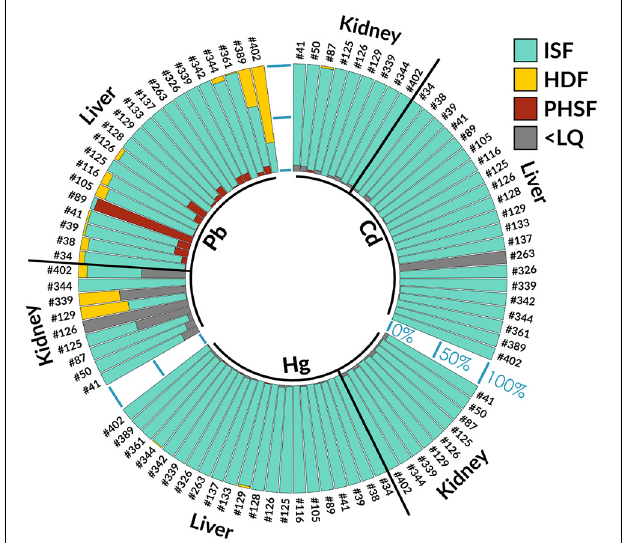
FIGURE 2 | Cd, Pb, and Hg metal compartmentalization results in Guiana dolphin ( Sotalia guianensis ) liver and kidney. ISF, insoluble fraction; HDF, heat-denaturable fraction; PHSF, purified heat-stable fraction; < LQ, lower than the limit of